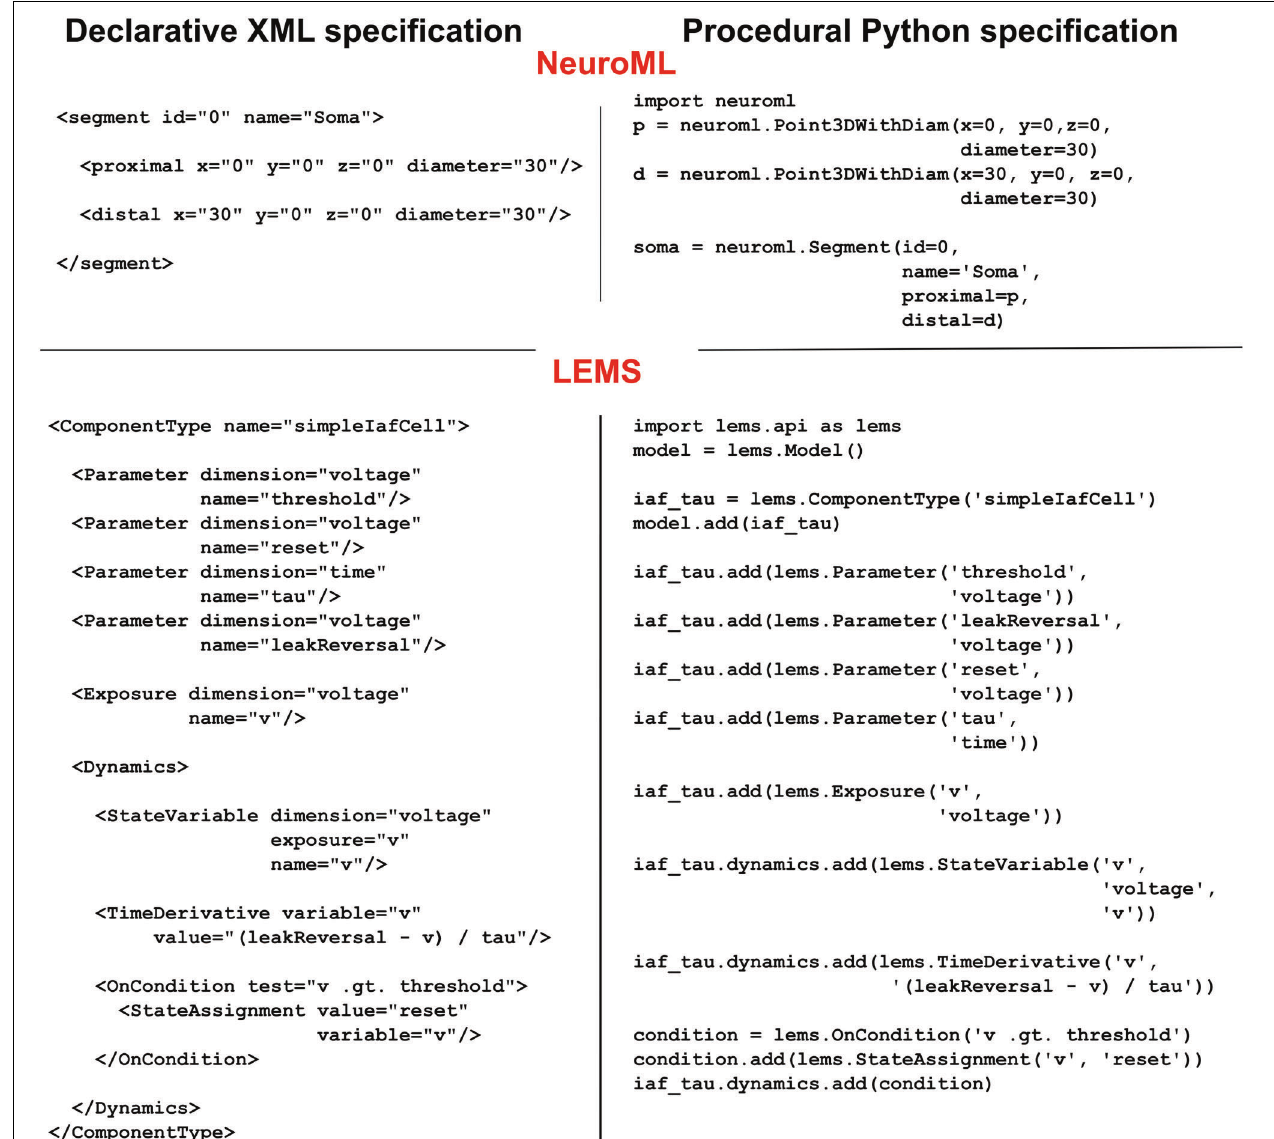
FIGURE 3 | Examples of NeuroML and LEMS models specified in XML and equivalent models specified with Python using the libNeuroML and PyLEMS APIs, respectively. The XML code on the left is generated